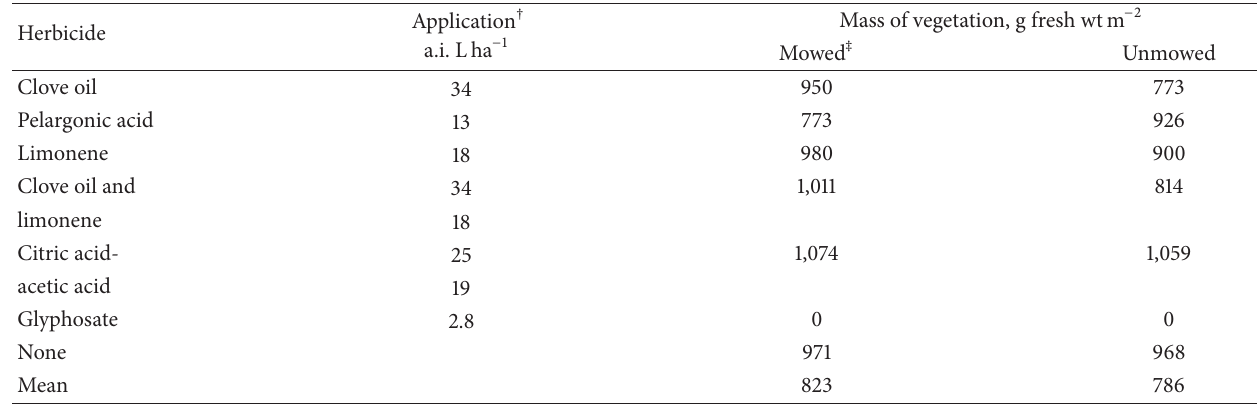
Table 13: Mass of vegetation harvested from plots treated with alternative herbicides or a conventional herbicide applied to mowed or unmowed roadside plots (Roadside Experiment